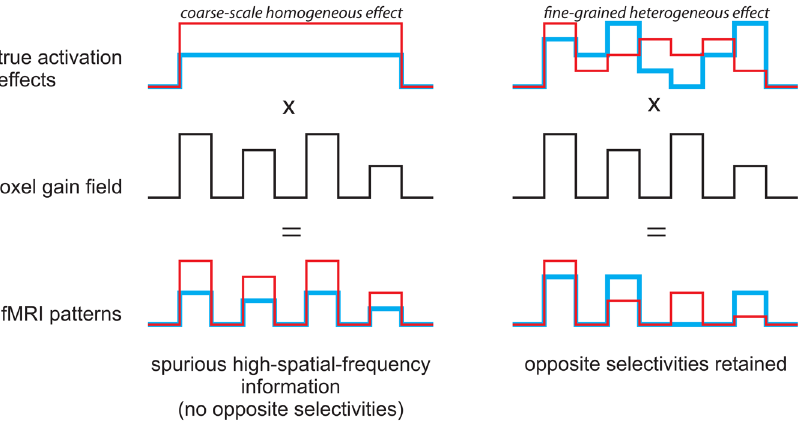
Figure 1. Coarse-scale neural effects can give rise to spurious high-spatial frequency fMRI pattern information in the presence of a high-spatial frequence gain field across voxels. An illustration of how differences in sensitivity to local activation across voxels (the voxel gain field) can lead to spurious high-spatial- frequency information in fMRI patterns. The left column shows the effect of a gain field on a coarse scale homogenous effect and the right column shows the effect of gain field on a fine-grained heterogeneous effect. An important property of the gain field effect is that the signs of the true activation effects are preserved. Spatial filtering analyses will suggest high-spatial frequency information in either scenario (left and right). However, the signature of a fine-grained heterogeneous effect (right) is the presence of local opposite selectivities (right only). Note that in actual data the sign of effects can be inverted by fMRI noise; this effect is not illustrated in this